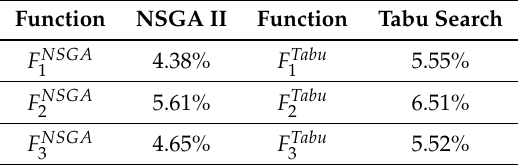
Table 2. Minimum damping of the three-machine—nine-busbar IEEE